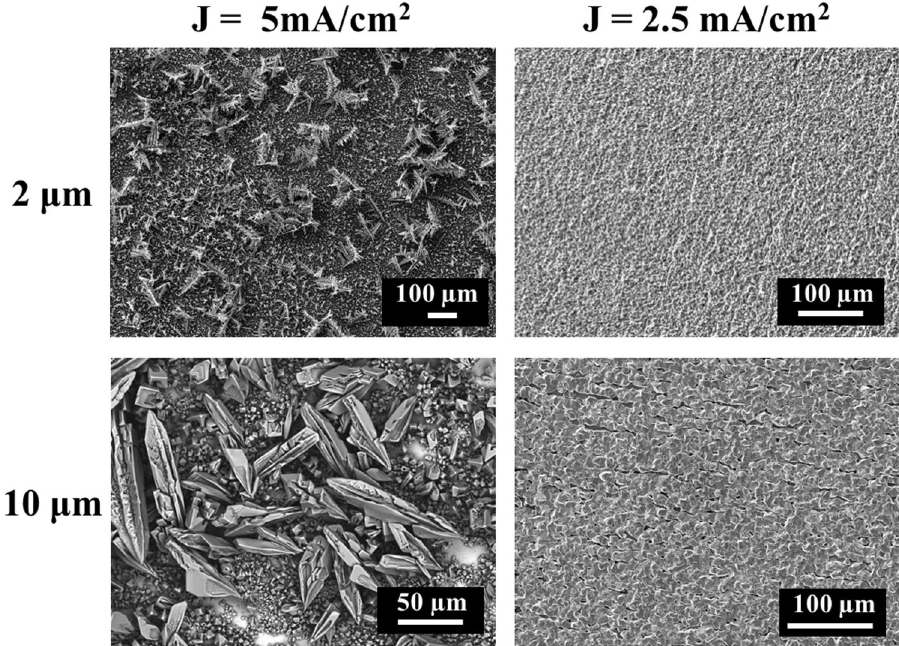
Figure 3. Electrochemical deposition of (2 and 10) μ m thick Sn films at current densities of (2.5 and 5) mA/cm 2